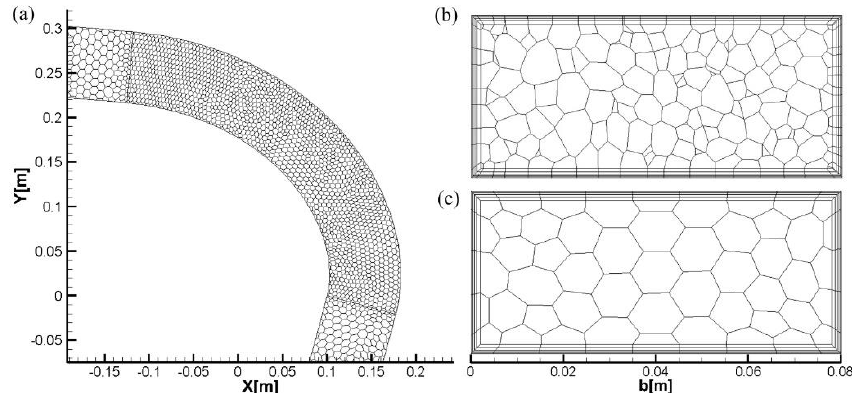
Figure 7. Scheme of polyhedral mesh: ( a ) Top view of the curved duct, ( b ) cross-section of θ = 80°, and ( c ) inlet of duct.